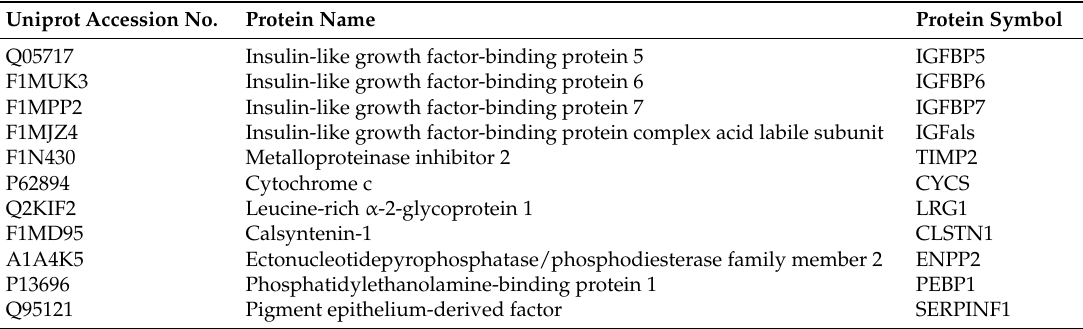
Table 4. BFF proteins with functional roles in signaling.